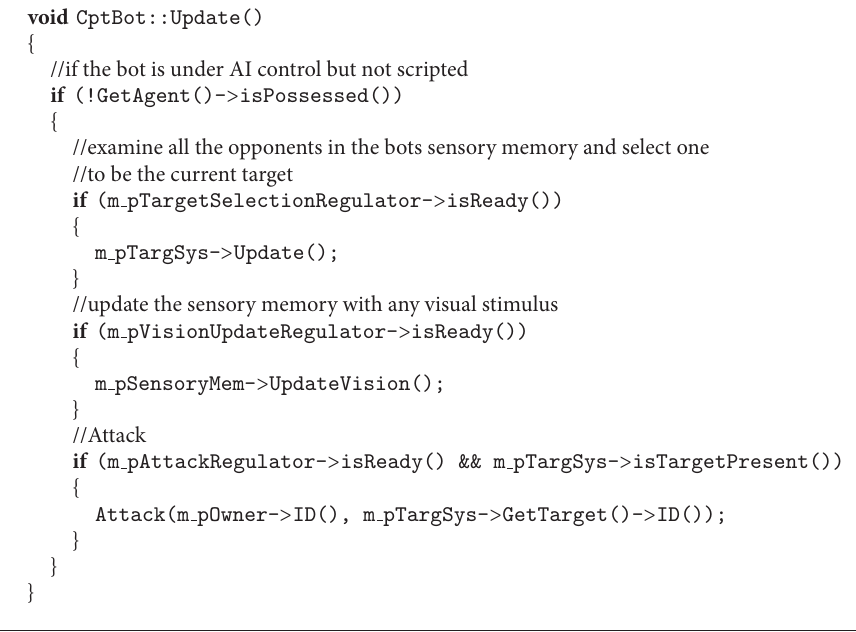
Algorithm 22: The update function of the CptBot class. The function uses the Attack conceptual control to issue commands to the units in the